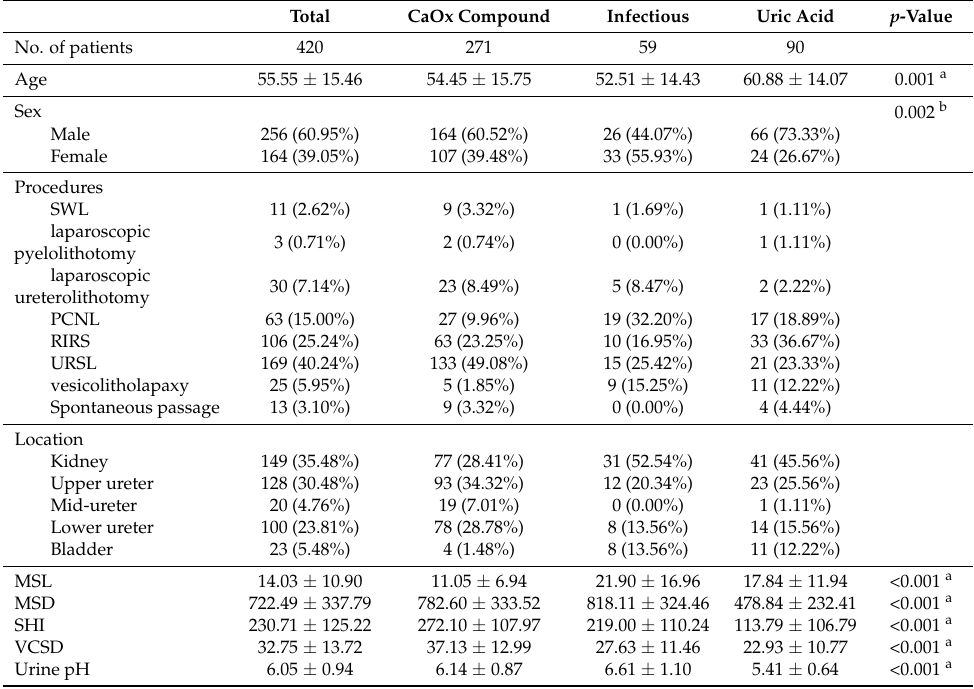
Table 1. Summary of patient and urinary tract stone characteristics according to composition of calculi (calcium oxalate, infectious, and uric acid stones). Total CaOx Compound Infectious Uric Acid p